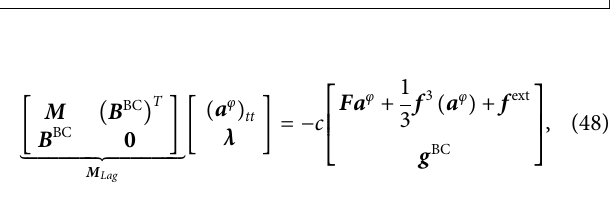
FIGURE4| Resultsoftheinitialvalueproblemsimulatedinthebeamtangentangle φ fordifferentexternalnodalforcesat l (cid:2) 0 . 5.Theresultsoftheactualinitialvalue calculation of φ pro fi les are shown on the left. A detailed explanation of the illustration is given in the caption of Figure 3 .